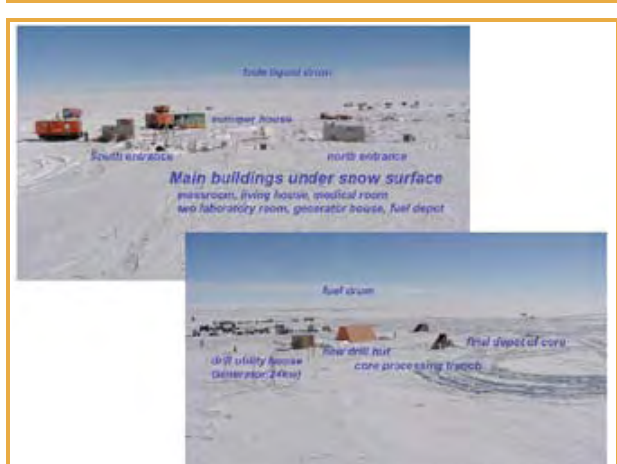
Figure 2. Dome Fuji station in January